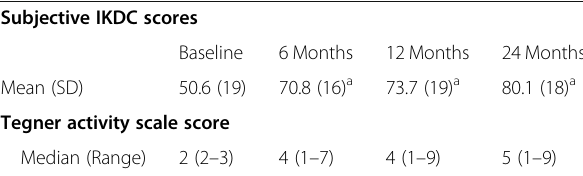
Table 3 Subjective IKDC score and Tegner Activty Scale scores at baseline and